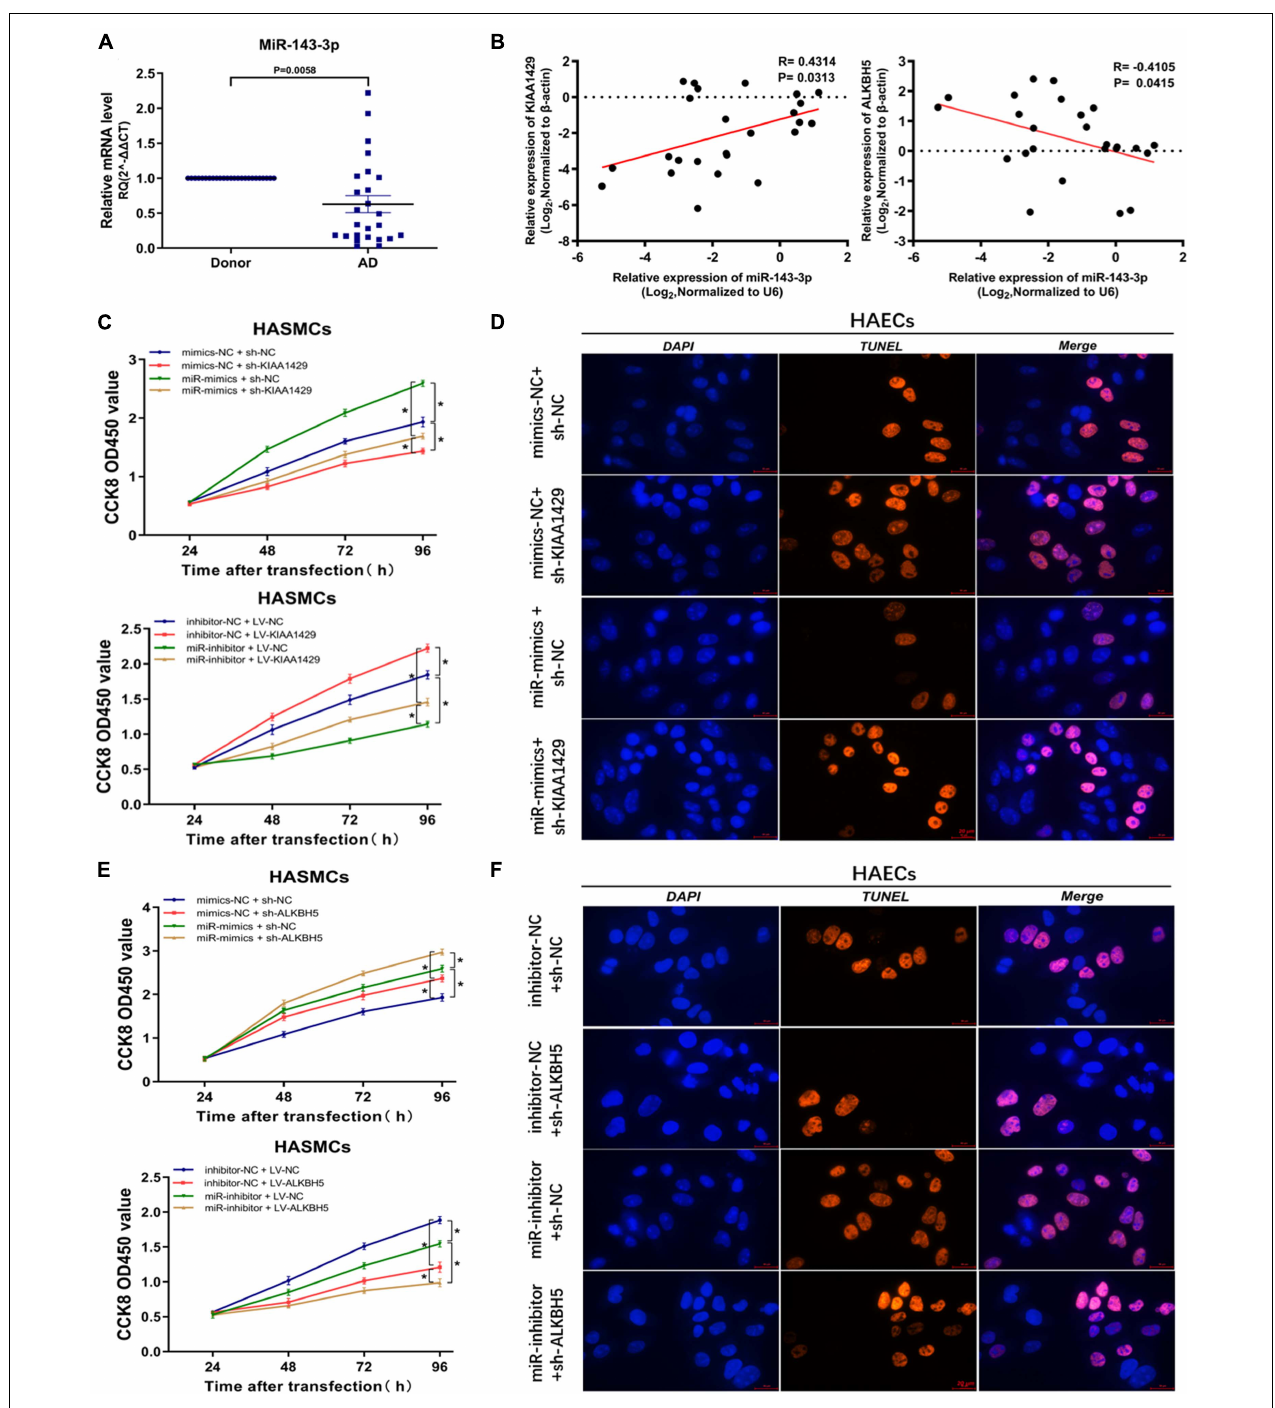
FIGURE 6 | MiR-143-3p is a downstream target of KIAA1429 and ALKBH5. (A) MiR-143-3p is significantly downregulated in aortic tissues from AD patients. (B) A positive correlation between miR-143-3p and KIAA1429 ( R = 0.4314, p = 0.0313) and a negative correlation between miR-143-3p and ALKBH5 ( R = –0.4105, p = 0.0415) were identified by Pearson’s correlation coefficient analysis. (C) MiR-143-3p upregulation could partly restore the cell proliferation suppressed by KIAA1429 knockdown and downregulation of miR-143-3p could partly decrease cell multiplication promoted by KIAA1429 overexpression. (D) TUNEL apoptosis assay showed that enrichment of miR-143-3p could partly attenuate HAEC apoptosis induced by the silence of KIAA1429. (E,F) Upregulation of miR-143-3p could enhance the pro-proliferative effect of ALKBH5 knockdown on HASMCs and downregulation of miR-143-3p could weaken the anti-apoptotic effect of ALKBH5 knockdown on HAECs. Data are presented as the mean ± SEM ( N ≥ 3 per group); * p < 0.05.